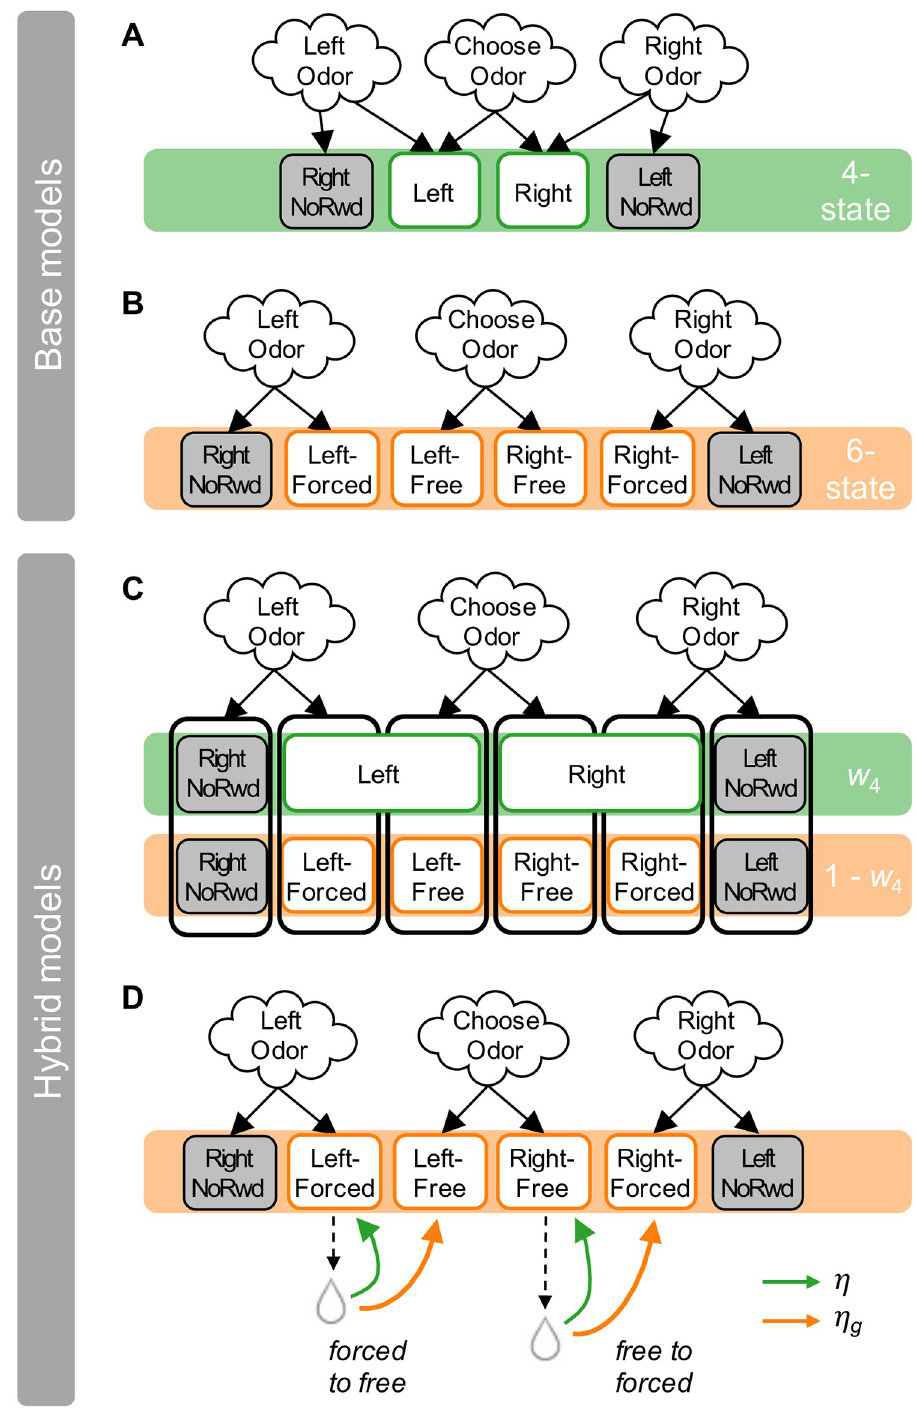
Fig 2. State representations of RL models. (A) The four-state model : free-choice trials and correct forced-choice trials share the same “Left” and “Right” states; “Right-NoRwd” and “Left-NoRwd” are the corresponding states for incorrect forced-choice trials. This is the true structure of the task as designed by the experimenters, as the same reward was available in forced-choice trials and free-choice trials if a correct choice was made. (B) The six-state model : each of the three odors leads to one of two states for left and right choices, with no generalization across odors. (C) The hybrid-value model : this model uses both the four-state and six-state representations (with a total of 10 states), with state values combined using weights w 4 and (1 − w 4 ) (illustrated as vertical boxes). (D) The